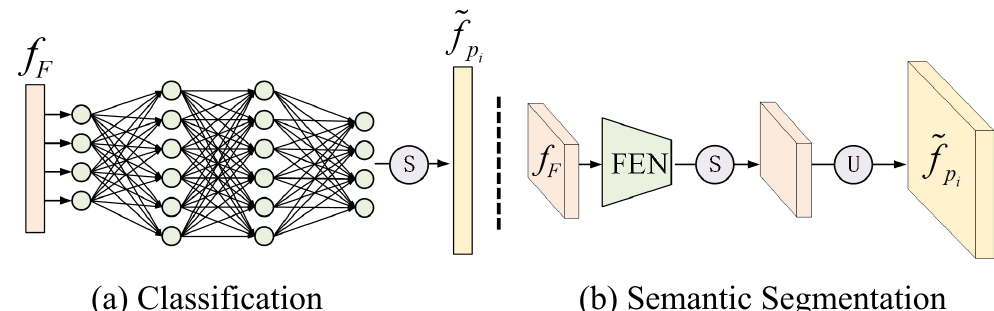
Figure 4. Task predictor networks. Different task predictor networks are proposed for three classification-based downstream tasks. For ( a ) image- and pixel-wise classification tasks, the predic- tor is implemented by fully connected layers. For ( b ) semantic segmentation task, the predictor is implemented by a feature enhancement network (FEN) and a upsample operator. ‘U’ represents the upsample operator and ‘S’ means soft-max operator.